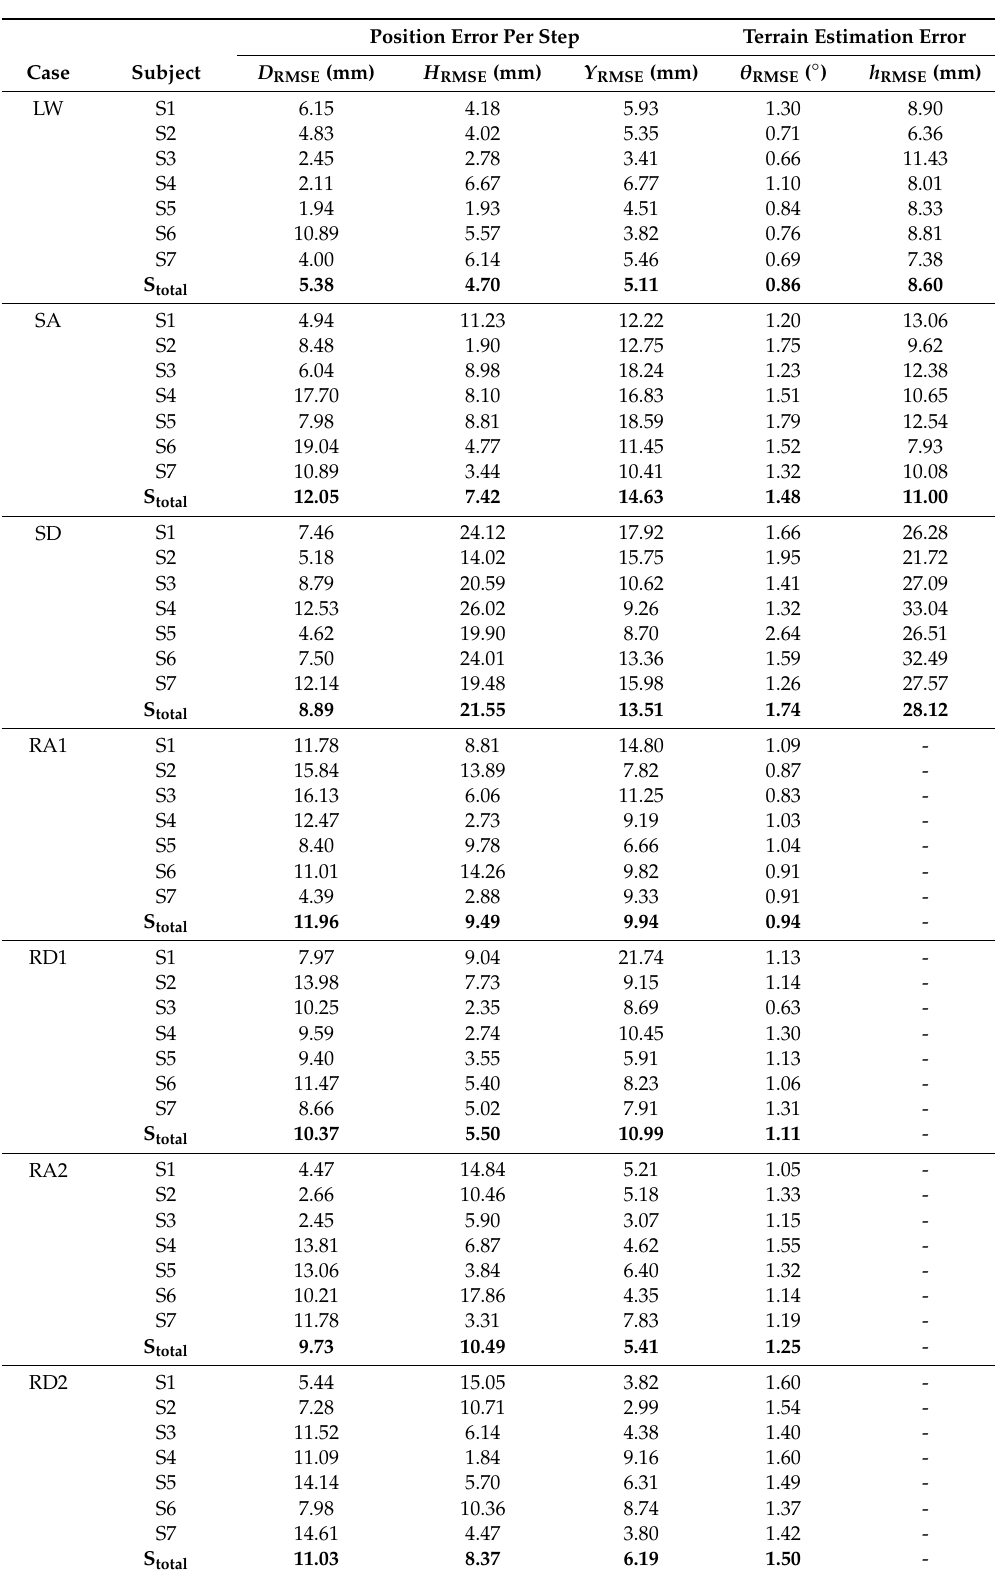
Table 5. Position error per step and terrain feature estimation error for each